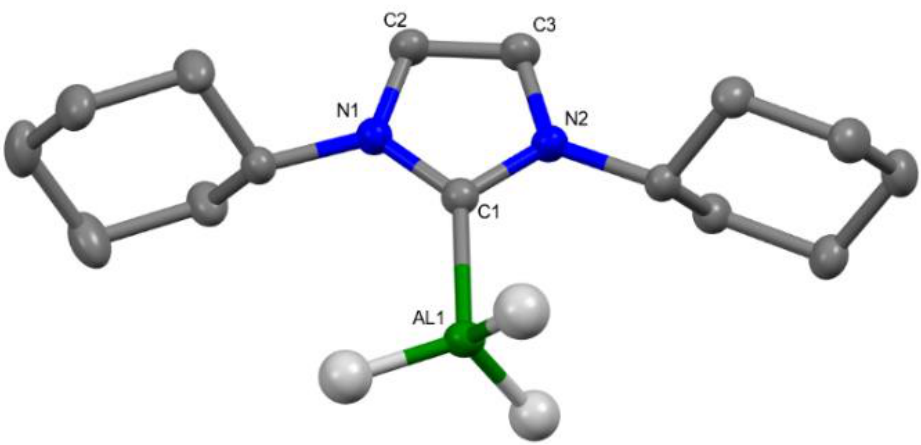
Figure 4. Solid-state structure of ICyAlH 3 ( 2 ) with ellipsoids drawn at 50 % probability. Hydrogen atoms other than those on aluminium have been omitted for clarity. Selected bond lengths (Å) and angles ( ◦ ): Al(1)–C(1) 2.055(11), C(1)–N(1) 1.3544(14), C(1)–N(2) 1.3835(14), C(2)–C(3) 1.3512(16), Average Al-H 1.527, N(1)–C(1)–N(2) 104.83(9).